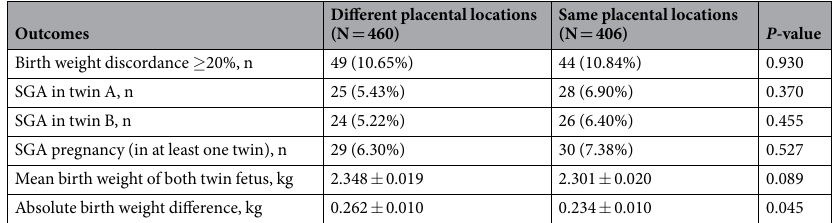
Table 2. Neonatal outcomes by placental location in univariate analysis. Note: SGA, small for gestational age.